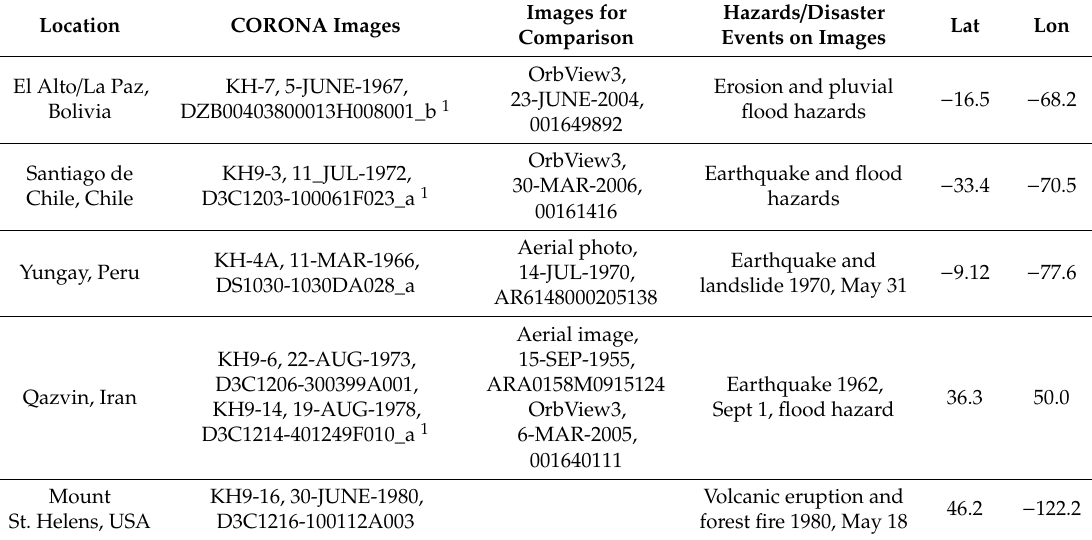
Table 3. High-resolution CORONA images, aerial photography and OrbView3 satellite data used for visual interpretation (based on information by